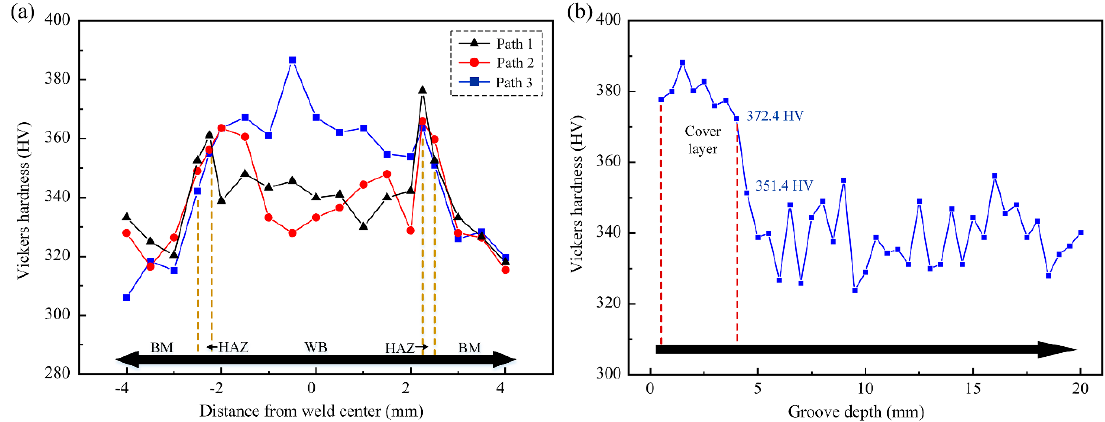
Figure 12. The Vickers hardness test results of welded joints: ( a ) path 1—path 3, ( b ) path 4.